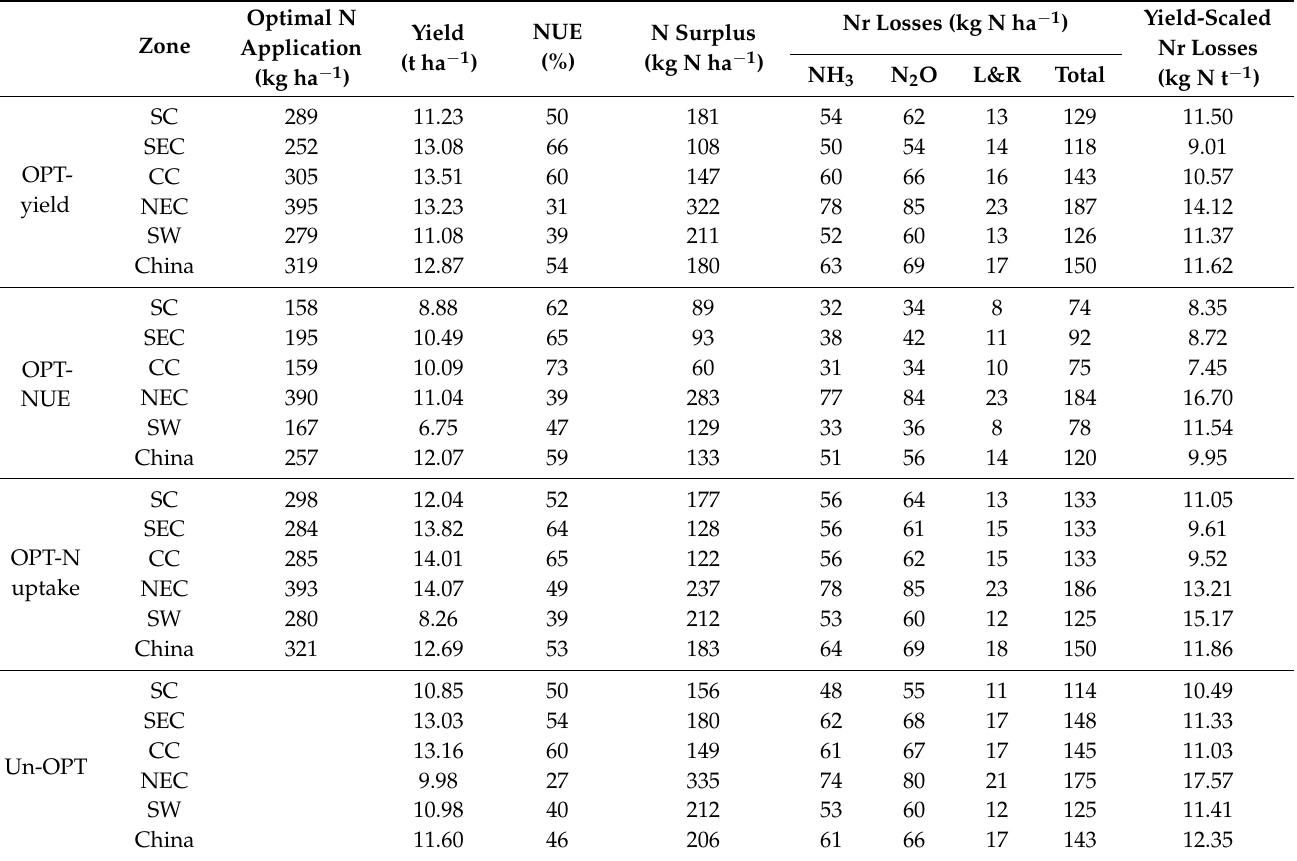
Table 2. Yield, NUE, N surplus, and yield-scaled Nr loss responses to three optimal N applications in